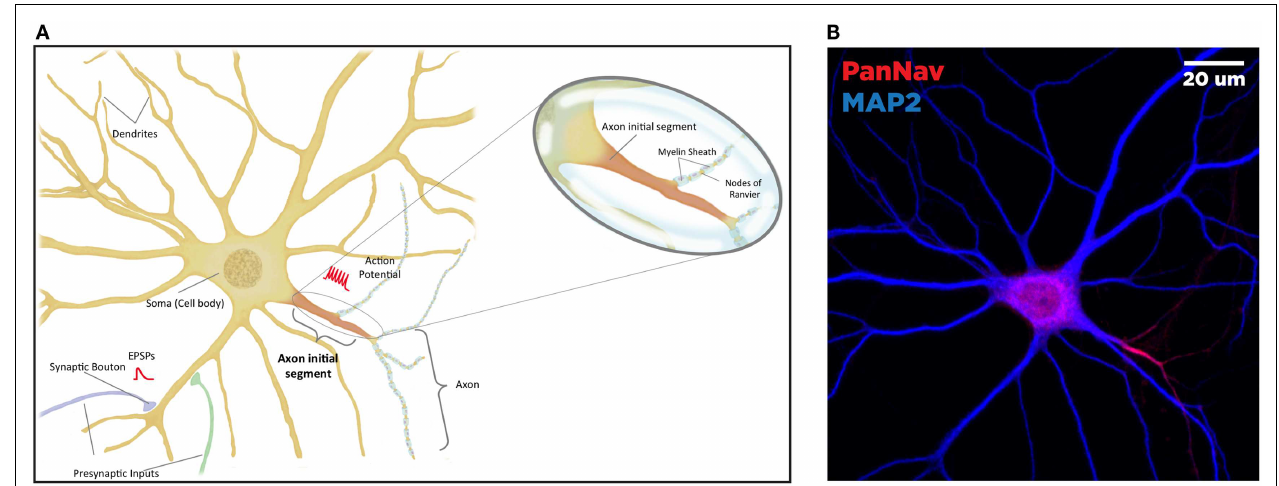
ions through voltage-gated sodium (Nav) and potassium (Kv) channels. These channels are highly enriched at the axonal initial segment (AIS), a protein-dense region that functions as the site of action potential initiation. Ion channels are also found in high concentrations at the nodes of Ranvier, gaps in the insulating myelin sheath surrounding the axon that allow for rapid, or salutatory propagation of action potentials. (A) Schematic of the neuron. Excitatory postsynaptic potential (EPSP) and action potential (AP) shown in red, at the synaptic bouton and the axon initial segment, respectively. (B) Confocal microscopy of a primary rat hippocampal neuron, labeled with anti-PanNav (red) and anti-MAP2 (blue) antibody visualizing axonal and somatodendritic compartments,